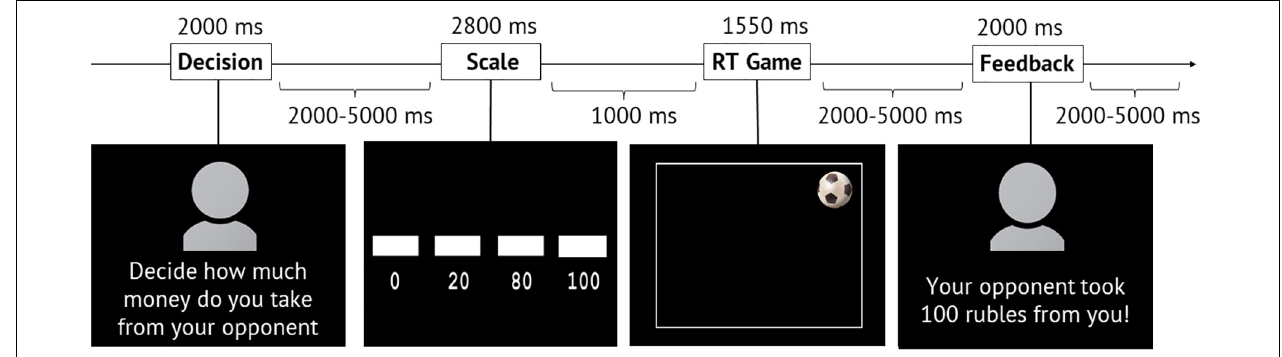
FIGURE 1 | Structure and temporal characteristics of the modified TAP paradigm. During the “Scale” phase, a scale indicating the amount of money was gradually filled, and the volunteer had to press the button when the box appeared above the selected amount. RT, reaction